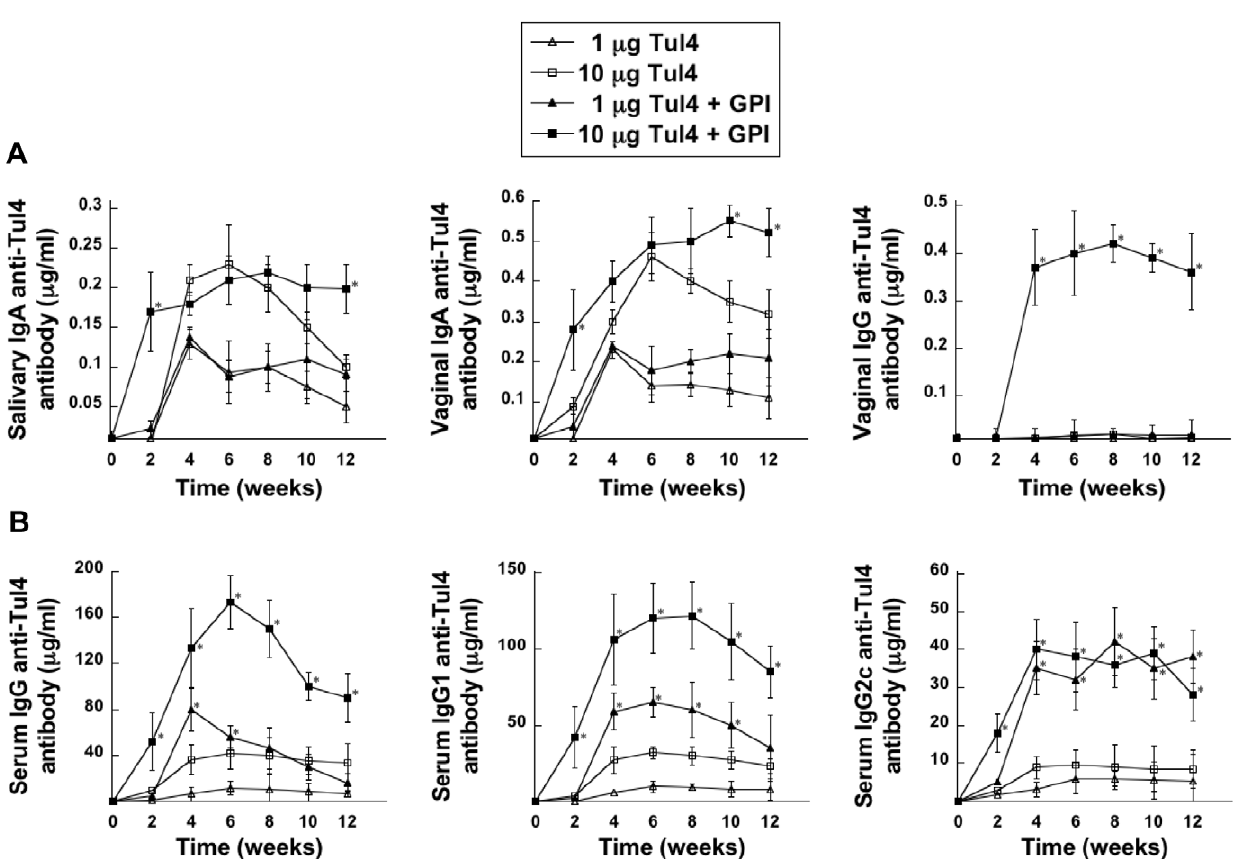
Figure 3. Tul4-specific mucosal and serum antibody responses following i.n. immunization with Tul4 + GPI. Mice were immunized via the i.n. route with Tul4 (1 or 10 m g) with or without GPI (100 m g) on days 0, 14 and 28. Individual saliva, vaginal wash and serum samples were collected prior to and at approximately 2-week intervals following immunization. Levels of Tul4-specific IgA in the saliva and vaginal wash samples and IgG in the vaginal wash samples (A), and of IgG, IgG1 and IgG2c in the serum (B), were determined by ELISA. There were 6 mice per experimental group and values are expressed as the mean 6 SEM. Significant differences were seen at P , 0.001 (*) compared with mice immunized with equivalent doses of Tul4 only.